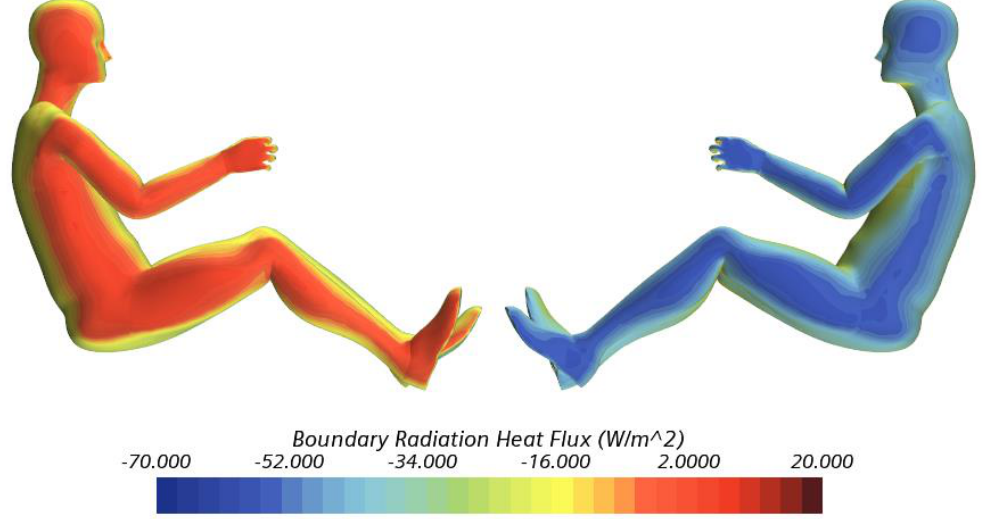
Figure 14. Radiation heat flux at the manikin at 25 °C inlet temperature.